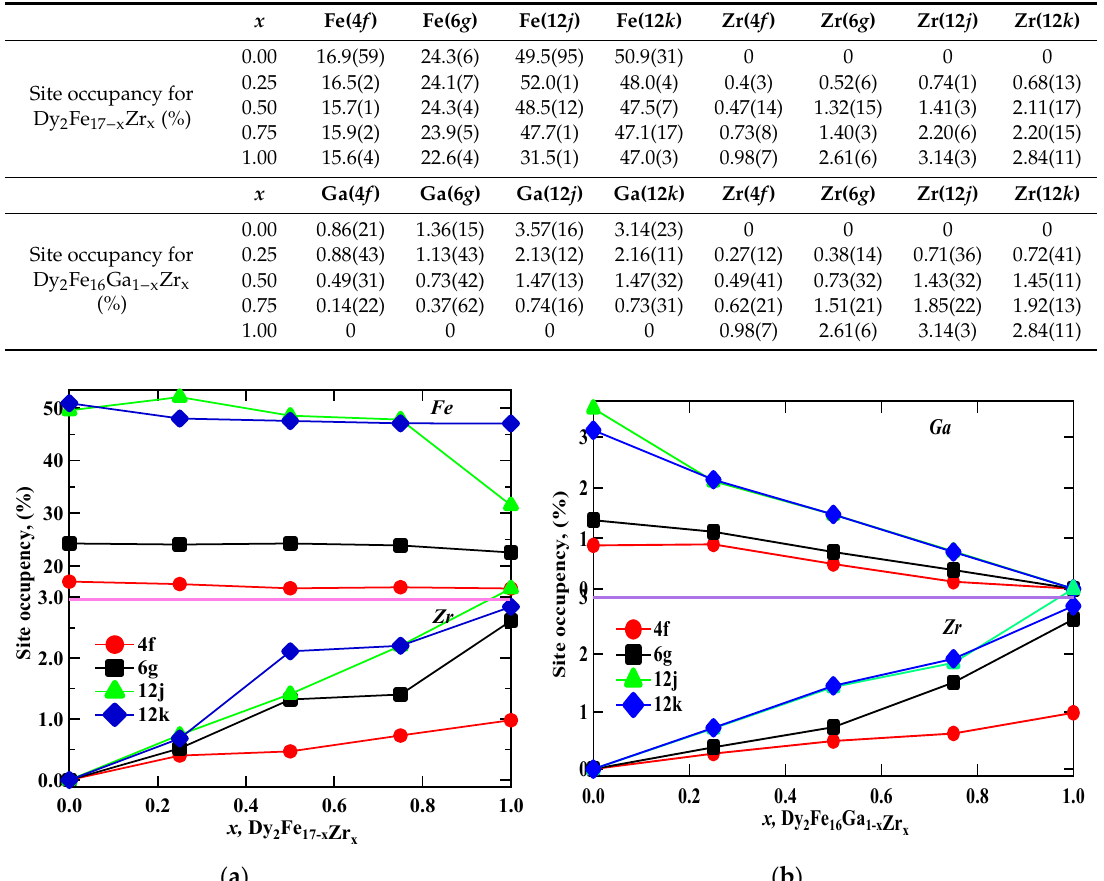
Figure 2. Lattice parameters a and c and unit cell volume of ( a ) Dy 2 Fe 17 − x Zr x and ( b ) Dy 2 Fe 16 Ga 1 − x Zr x as a function of Zr content. Table 2. The site occupancy table for Dy 2 Fe 17 − x Zr x , and Dy 2 Fe 16 Ga 1 − x Zr x .